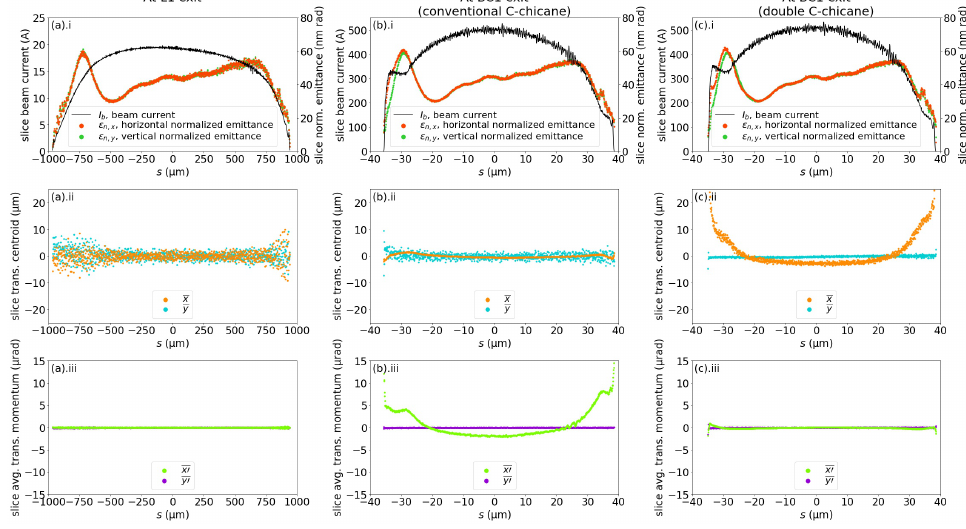
Figure 5. Performance comparison of BC1 configurations in a conventional C-chicane (lattice 1) and a double C-chicane (lattice 2). The electron beam is divided into 1000 slices ( a ) at the exit of L1, ( b ) at the exit of BC1 using a conventional C-chicane, and ( c ) at the exit of BC1 using a double C-chicane. ( a ). i , ( b ). i , and ( c ). i show the normalized emittances and the currents of each slice along the beam; ( a ). ii , ( b ). ii , and ( c ). ii show the distributions of the transverse centroids; ( a ). iii , ( b ). iii , and ( c ). iii show the distributions of the average transverse momentum shifts. Table 2. Twiss parameters and other beam properties at L1 exit. Beam energy 750